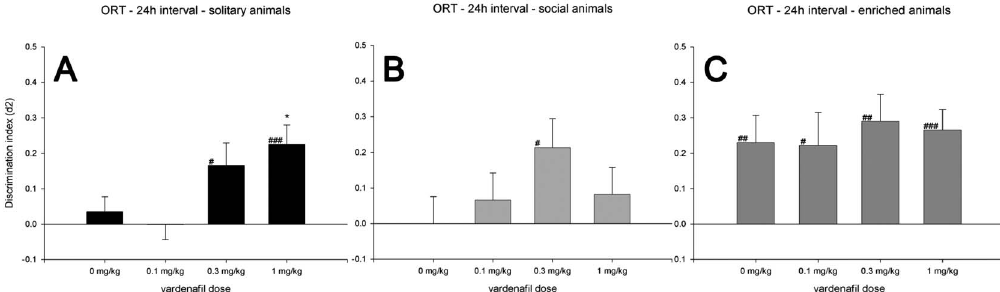
Figure 3. ORT 24 h intervals. Discrimination performance (d2, mean + SEM) of SOL (A), SOC (B) and EE (C) rats after administration of different doses of vardenafil in the object recognition task. All housing conditions were tested in a 24 h retention interval in combination with 0, 0.1, 0.3 and 1 mg/kg vardenafil (x-axis). A difference from zero is indicated with hash symbols (one-sample t -test; # : p , 0.05; ## : p , 0.01; ### : p , 0.001), differences from the vehicle condition (0 mg/kg) within the same retention interval are indicated with an asterisk (Tukey HSD; *: p , 0.05). Of note, the 0 mg/kg vardenafil conditions are identical to those used in Figure 2.